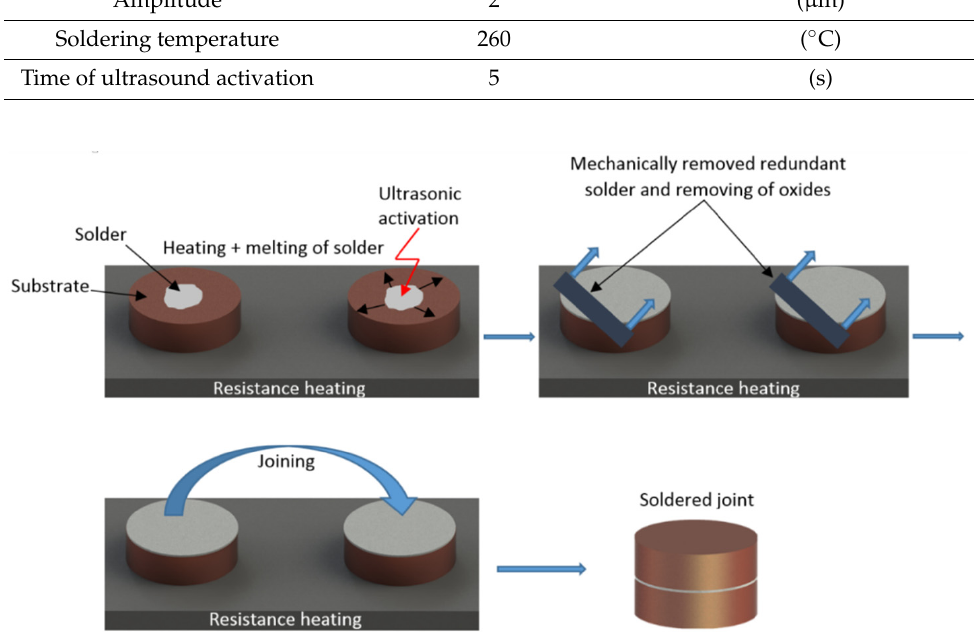
Figure 4. Schematic representation of the soldering process in the presence of ultrasonic power. Metallographic preparation of specimens from soldered joints was realized by standard metallographic procedures used for specimen preparation. Grinding was performed using SiC emery papers with 240, 320, and 1200 grains/cm 2 granularity. Polishing was performed with diamond suspensions with grain size 9, 6, and 3 μ m. The final polishing was performed using of polishing emulsion OP-S (Struers) with 0.2 μ m granularity.